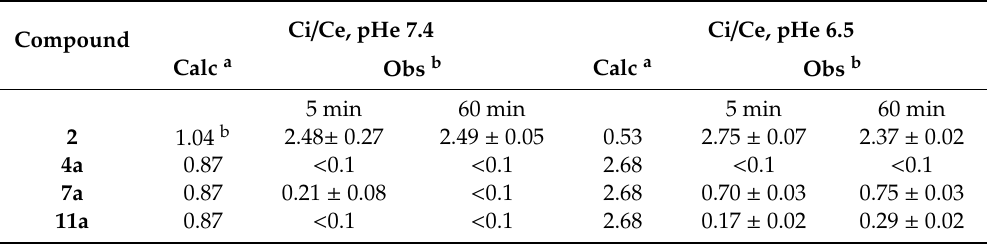
Table 8. Calculated Ci / Ce for pH-dependent partitioning based on measured pHi values and the observed Ci and Ce values from Figure